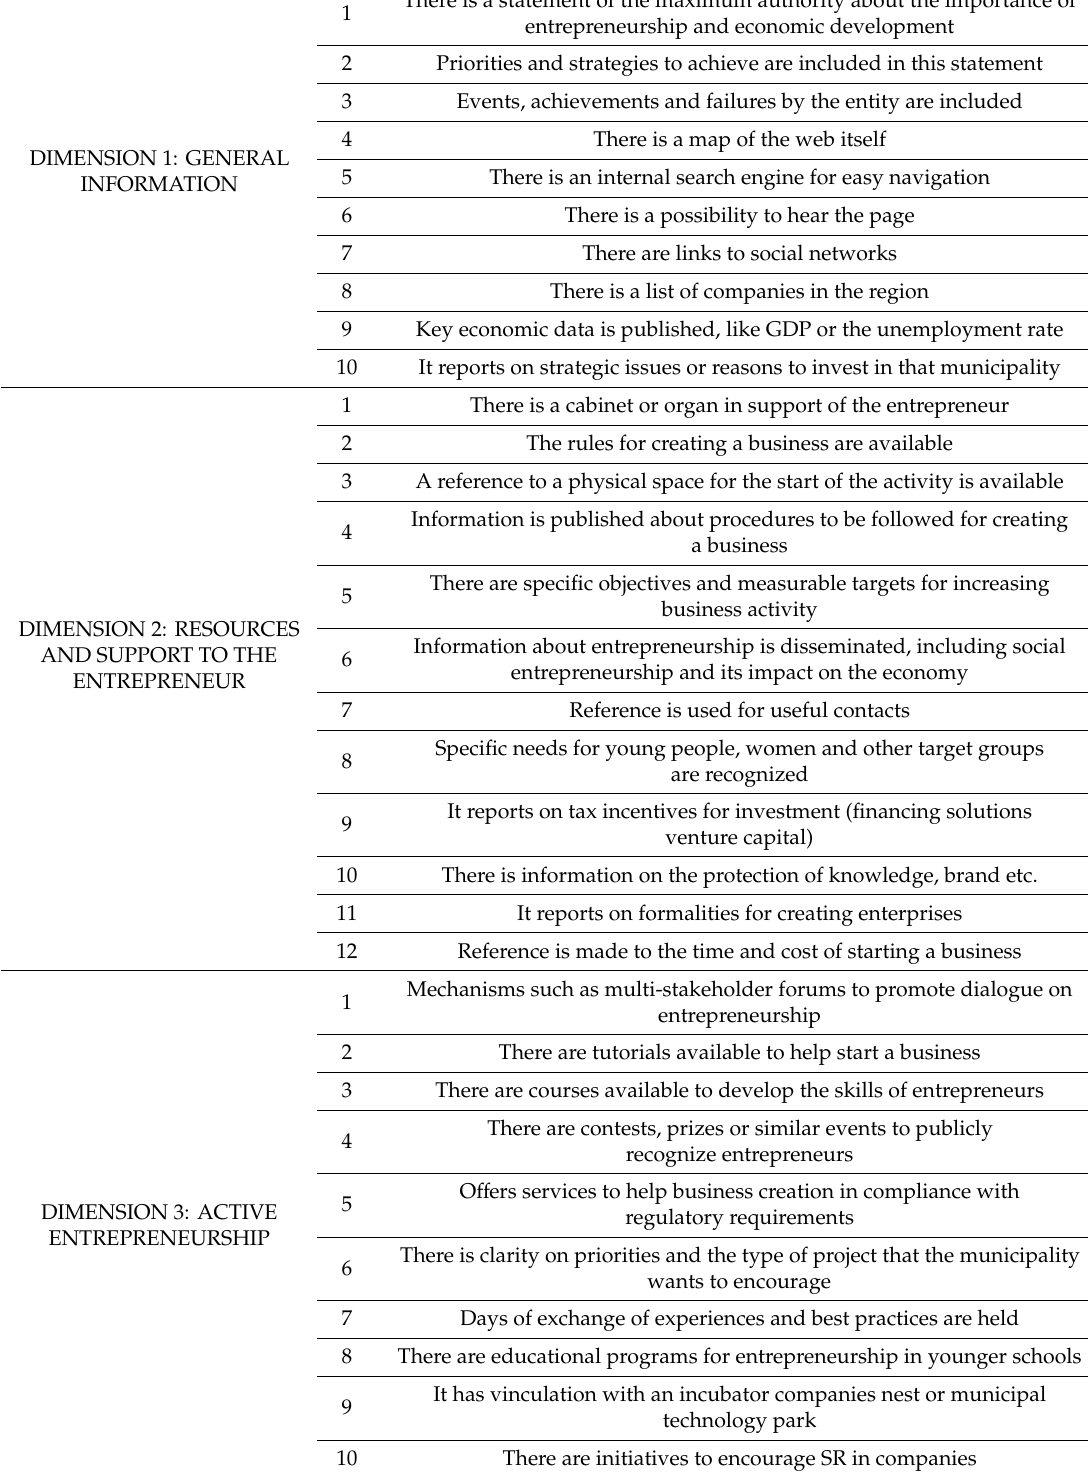
Table 2. List from the 49 indicators according to the dymension (source: Carvalho et al. 2017).